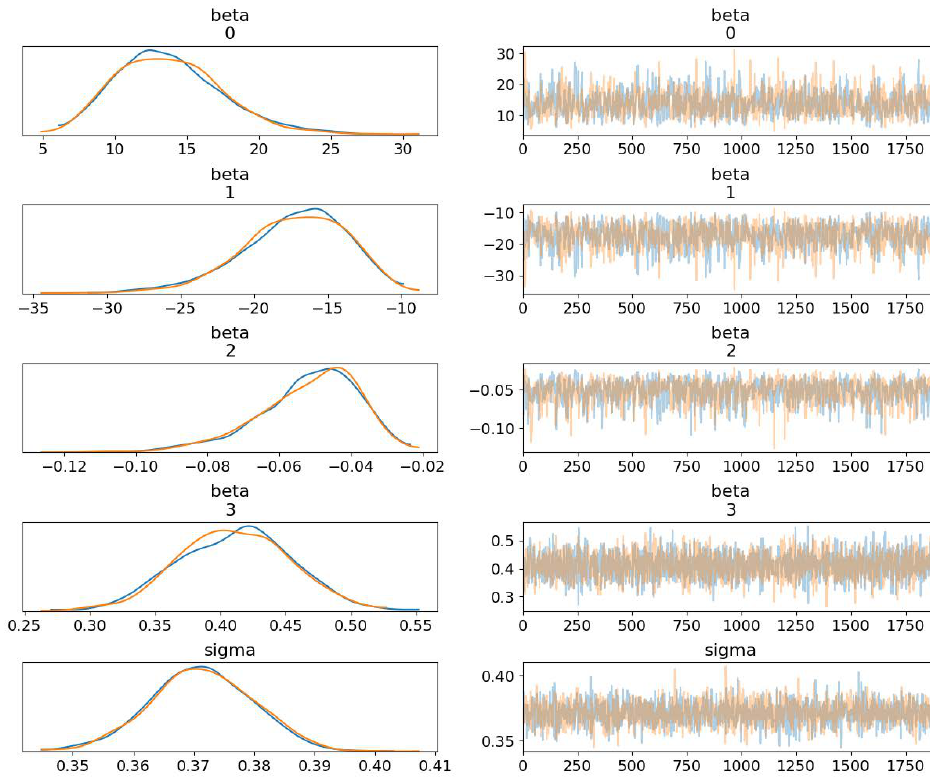
Figure 2. The estimated posterior distributions. The left-hand side is the marginal posterior distribution and the right-hand side is the sampling chain of each model parameter. The multi-process sampling is done in parallel and both demonstrate similar